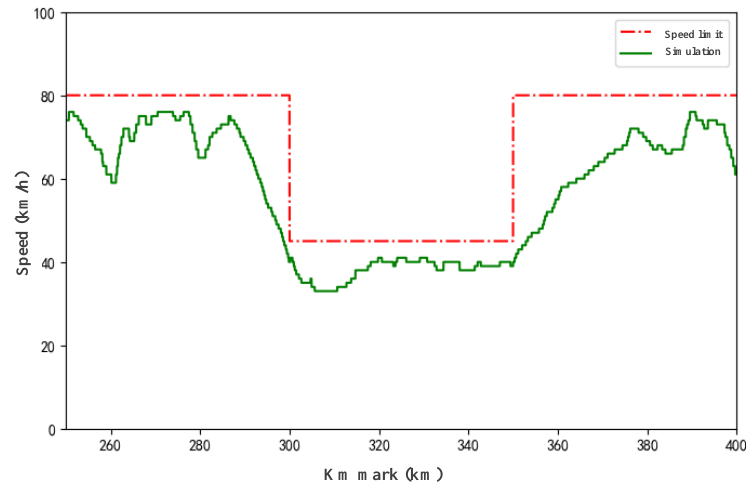
Figure 11. The v-s curve under temporary speed limit.